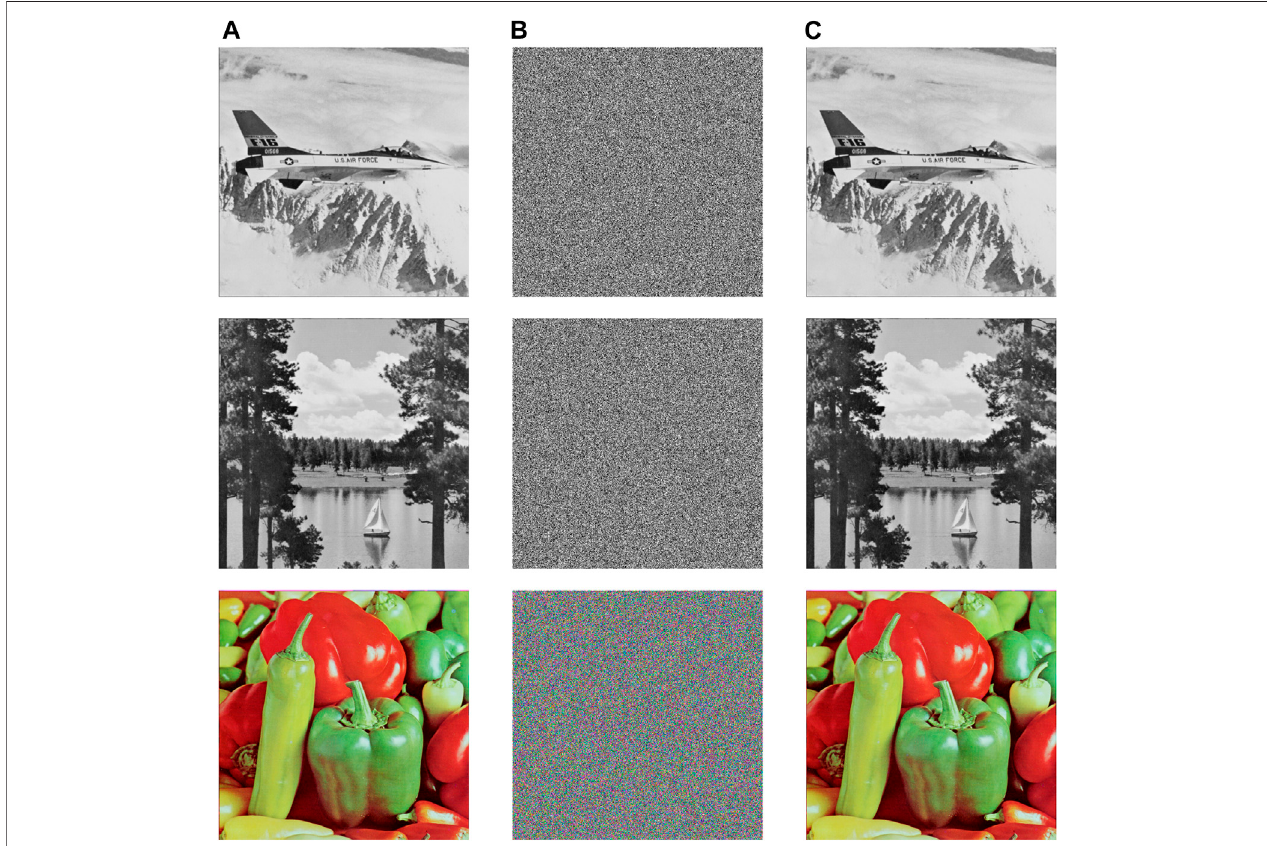
FIGURE 7 | Image encryption experiment results: original image (A) , encrypted image (B) , decrypted image (C) .